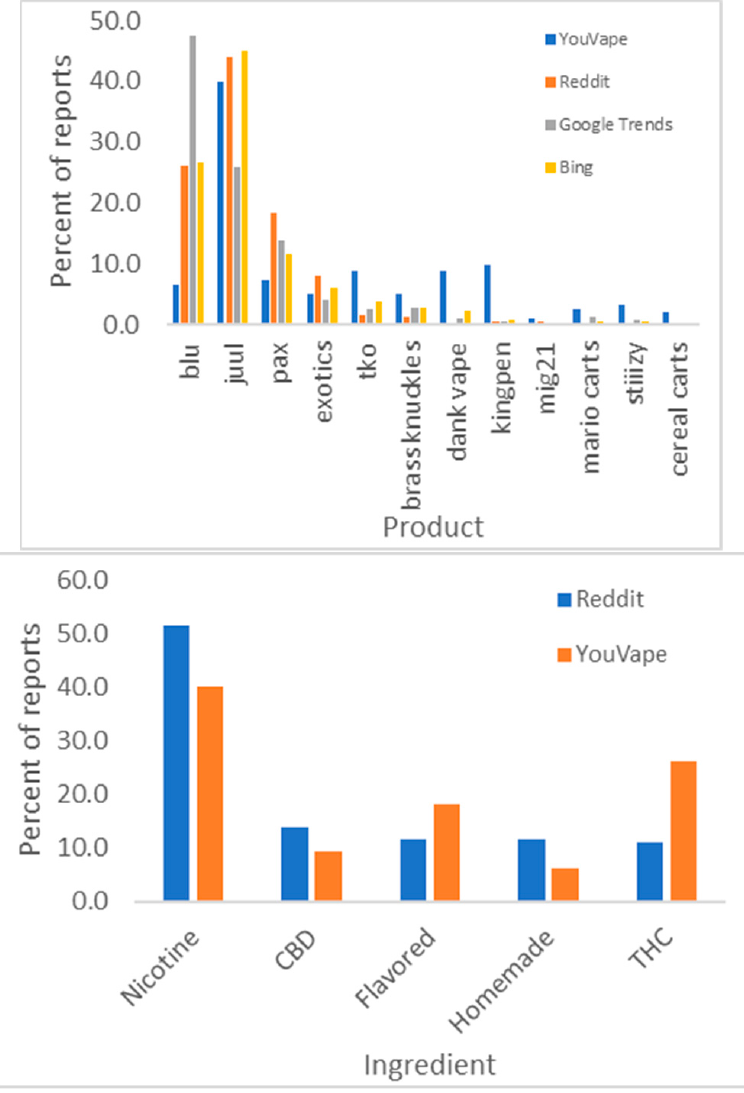
Figure 2. Product popularity in different data sources ( top ) and vaping ingredients ( bottom ). YouVape data shows that brand use is strongly associated with age (chi 2 test, chi = 140.6, p = 10 − 7 ) but not gender ( p = 0.3). Conversely, ingredients are not correlated with age ( p = 0.11), but are associated with gender (chi 2 test, chi = 56.8, p = 10 − 10 ). Google Trends provides the relative query volume from different states for the different products. Figure 3 shows maps of these query volumes. As the figure demonstrates, while some brands are popular across the US, others are concentrated geographically to specific areas. The correlation between the state-level Google Trends query volume and the fraction of Bing users from each state who queries for each brand were statistically significantly correlated (on average, Spearman rho = 0.66), except for TKO and Blu. We attribute the latter to the fact that these two names are short and